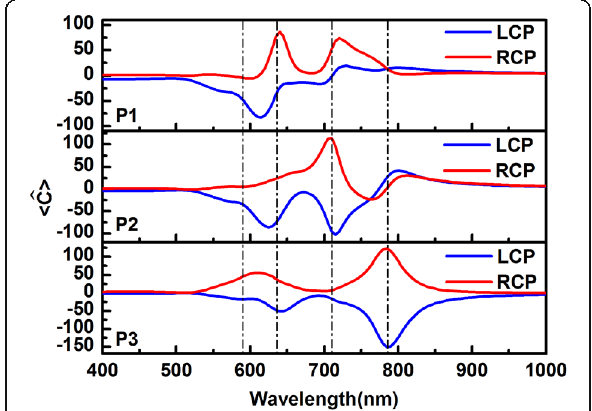
Fig. 7 Volume-averaged optical chirality enhancement factors in the gaps P1, P2, and P3. The blue and red solid lines correspond to LCP and RCP light excitation, respectively. The vertical dashed lines from left to right correspond to the peaks at 590, 635, 710, and 785 nm,